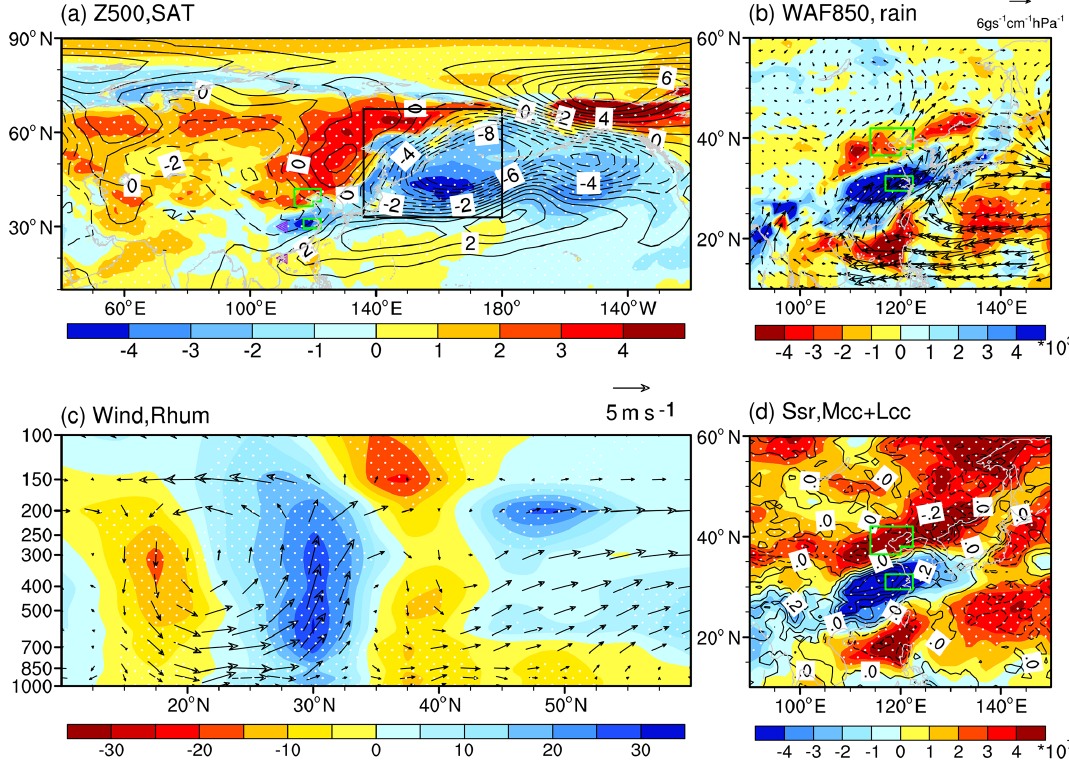
Figure 7. Differences of the daytime atmospheric circulations (i.e., PAT2P minus PAT2N): (a) geopotential height at 500hPa (unit: 10gpm, contours) and surface air temperature (unit: K, shading), (b) water vapor flux (unit: gs − 1 cm − 1 hPa − 1 ) at 850hPa (arrows) and precipitation (unit: mm, shading), (c) 100–120 ◦ E mean wind (unit: ms − 1 , arrows) and relative humidity (unit: %, shading), and (d) downward solar radiation at the surface (unit: 10 7 Jm − 2 , shading) and the sum of low and medium cloud cover (unit: 1, contours). The white dots indicate that the shading was above the 95% confidence level. The green boxes in panels (a) , (b) and (d) are the NC and YRD regions, and the black box in panel (a) indicates the location of the East Asian trough. The purple triangles in panel (a) indicate the data used to calculate the WPSH 2